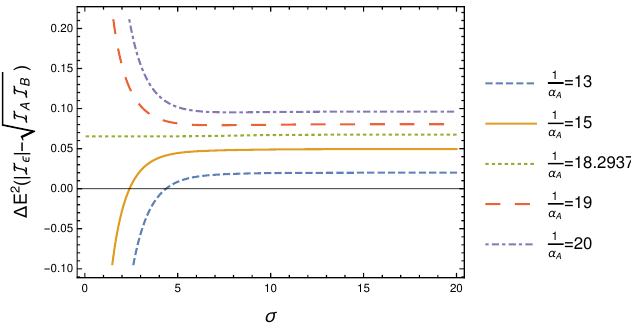
√ (cid:0) (cid:1) is plotted for two anti-parallelly |I ε | − I A I B = 1 B